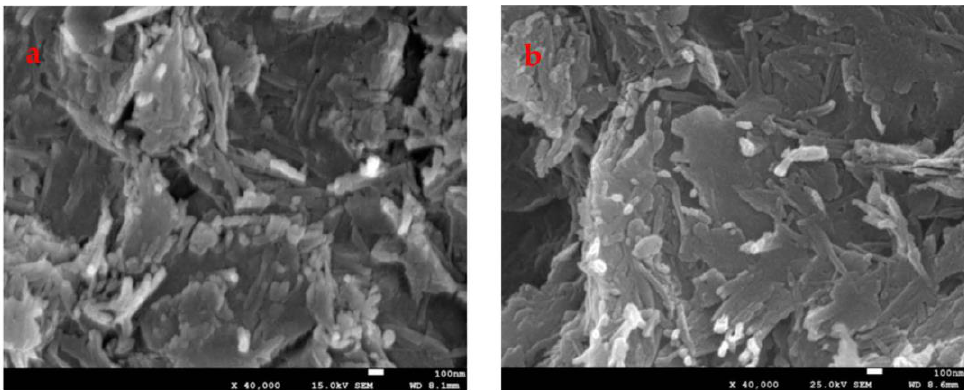
Figure 2. SEM image of catalyst before ( a ) and after ( b ) reaction